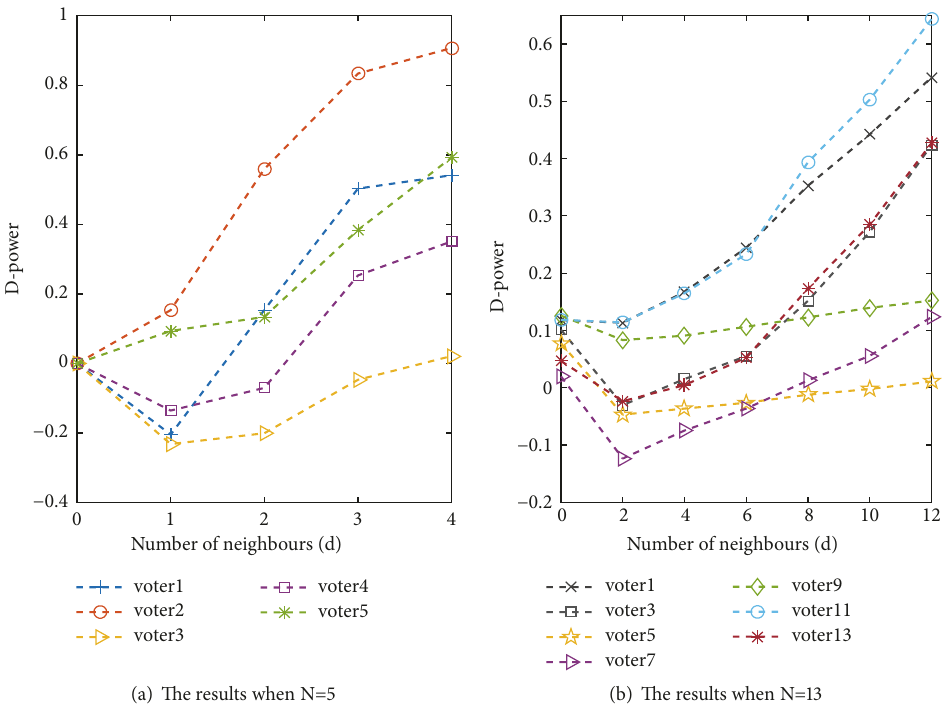
Figure 9: Robustness of voter’s neighbors influence. Subgraphs (a) and (b) show the simulation results of five players (i.e., 𝑁 = 5 ) and 13 players (i.e., 𝑁 = 13 ), respectively, in which voters play a repeated voting game in a social network with a 30% connection probability, accompanied by voter 𝑖 ’s neighbors 𝑑 𝑖 increasing from 𝑑 𝑖 = 0 to 𝑑 𝑖 = 8 while keeping the other parameters.